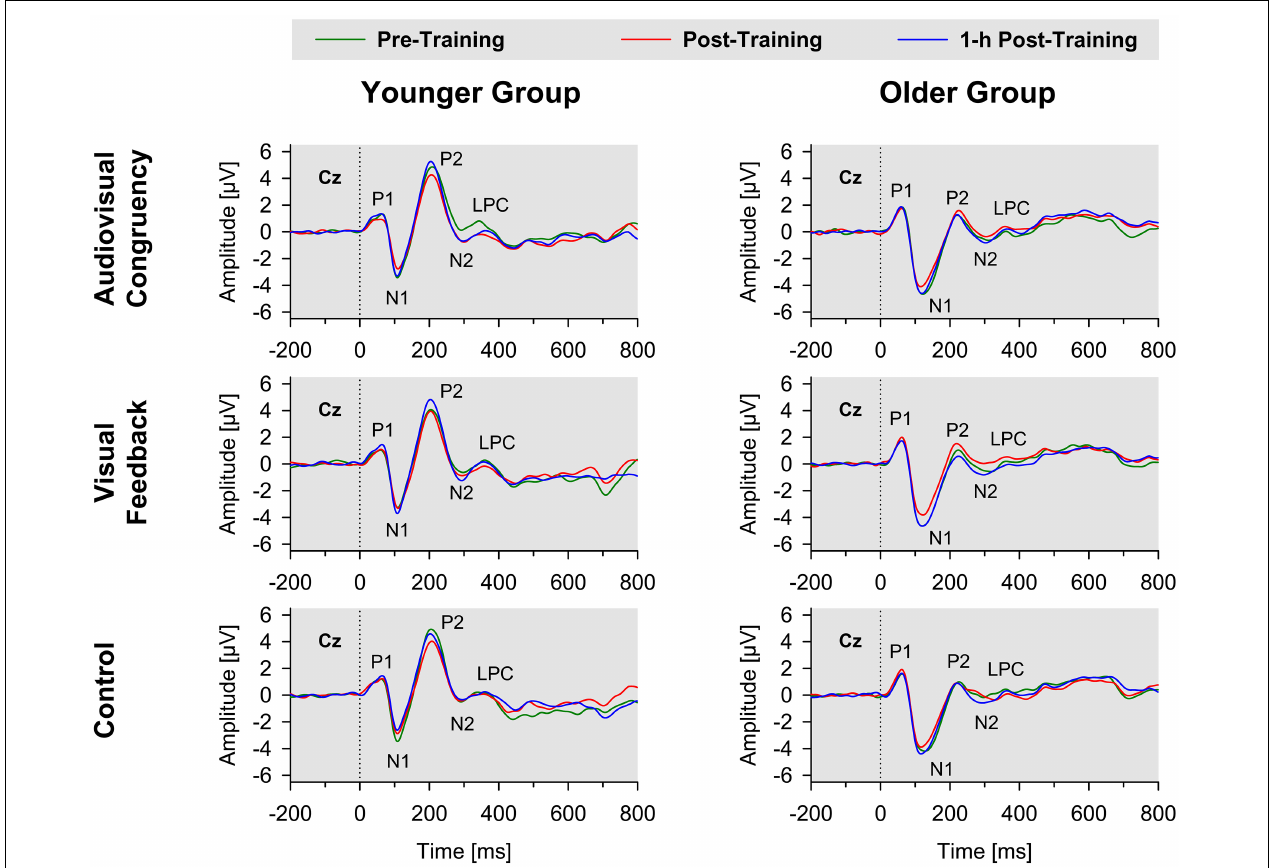
FIGURE 2 | Grand-average ERPs to stimulus onset for younger (left panels) and older participants (right panels) at Cz electrode position. Data obtained before training (pre-training), immediately after training (post-training), and 1 h after training (1-h post-training) are shown separately for audiovisual-congruency training, visual-feedback training, and control condition. P1, N1, P2, and N2 components and LPC are marked in each